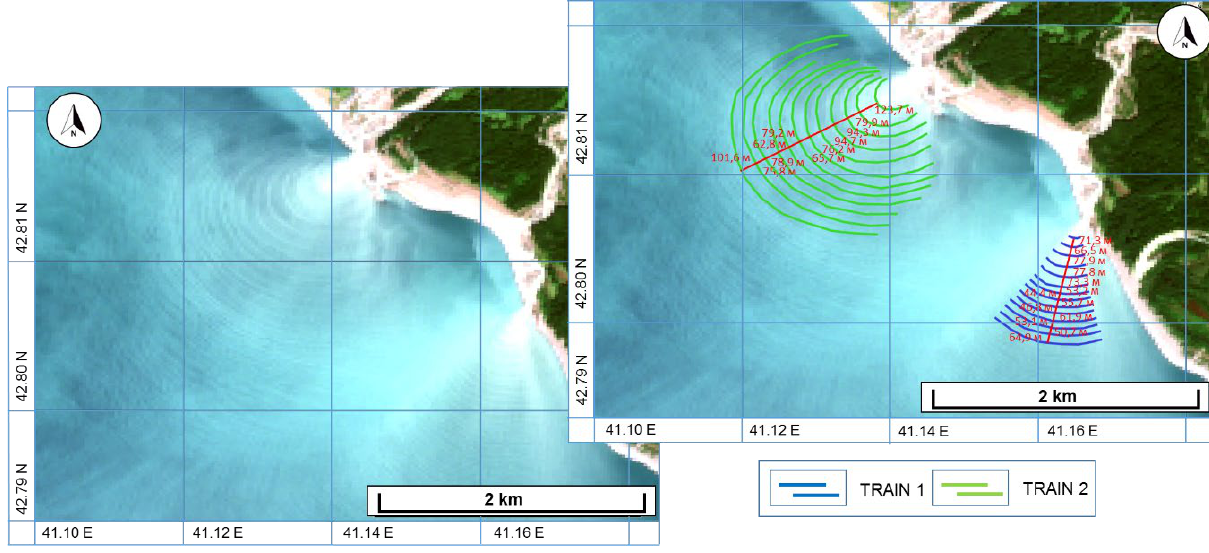
Figure 4. Fragment I of a satellite image (Sentinel-2, 10 September 2017) showing concentric ring structures at the confluence of the Kodor River into the sea.